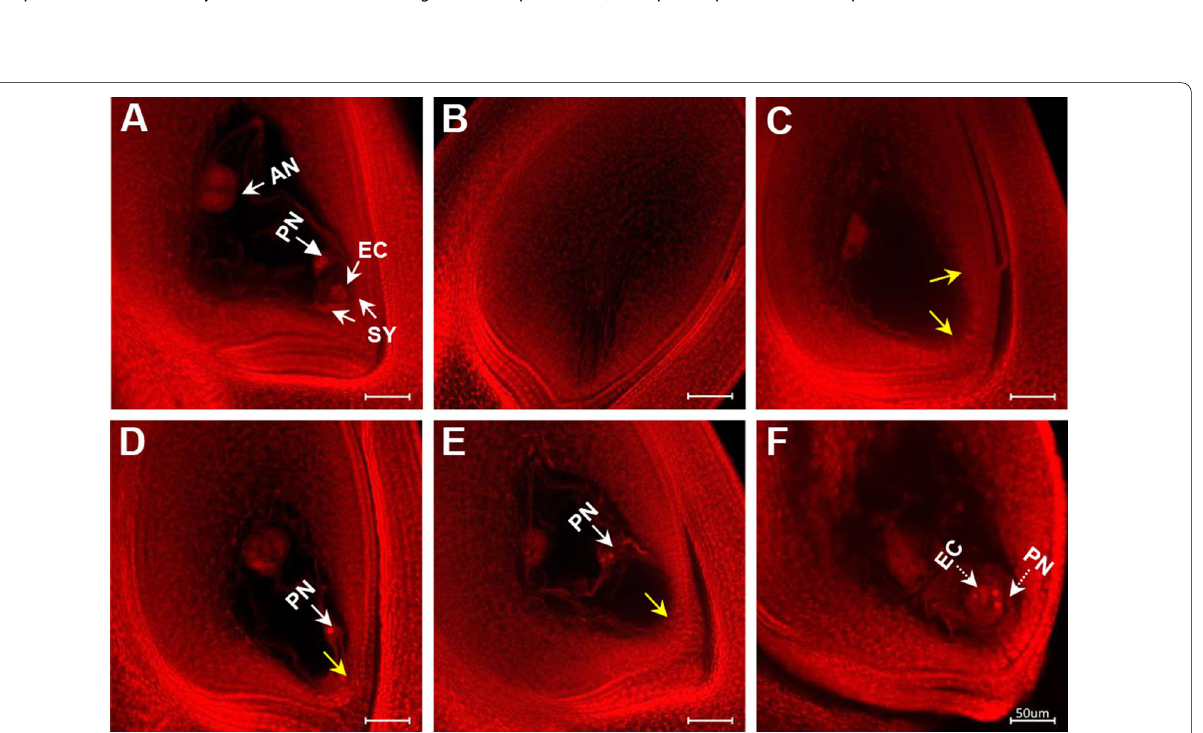
Data presented is the summary of heat stress induced damage across all spikelet sizes, with specific spikelet size details provided in Additional file 1: Table S1